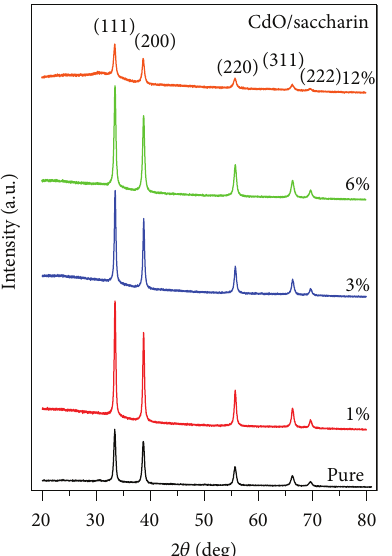
Figure 2: XRD patterns of CdO films as a function of saccharin con- centration.